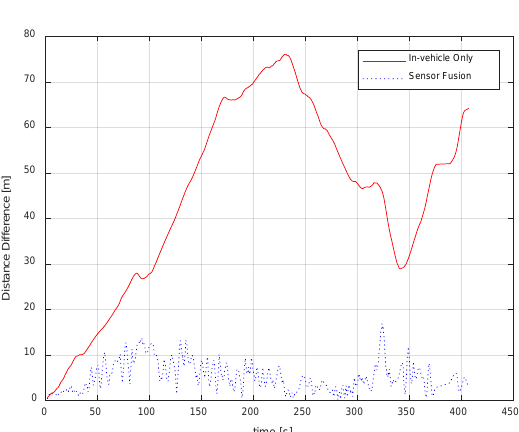
Figure 5. Trajectory comparison